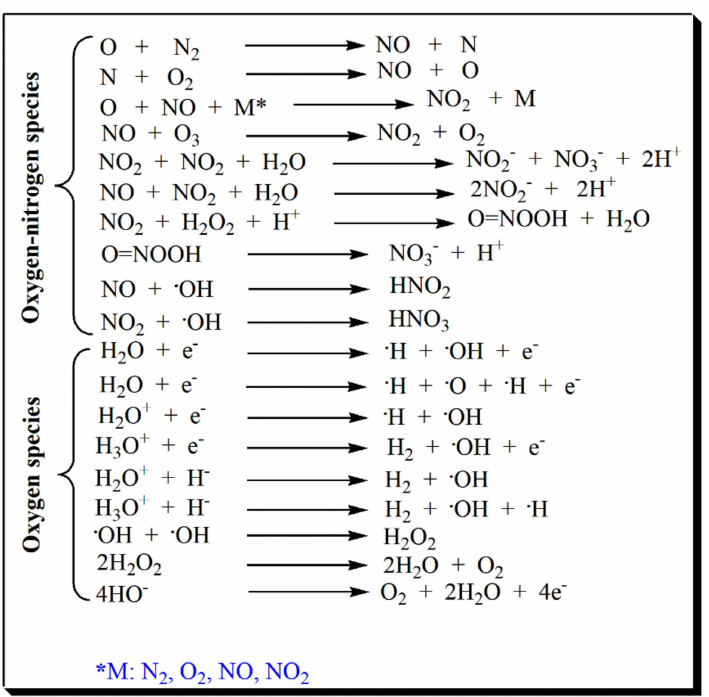
Figure 2. Potential reactive species formed with cold plasma treatment, using water and air atmo- sphere (N 2 + O 2